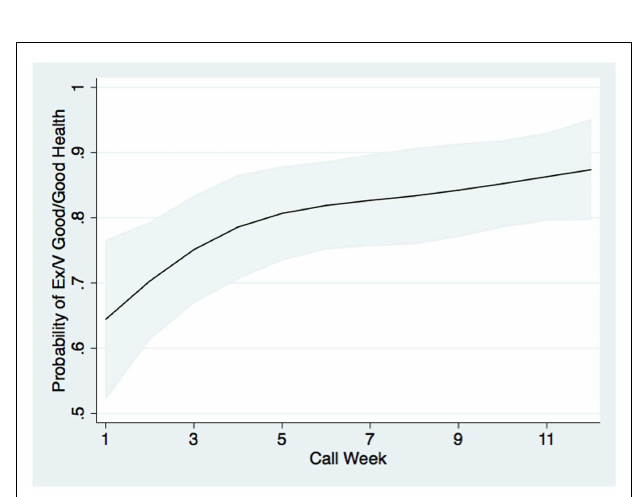
FIGURE 3 |The probability that patients completing an IVR call on a given week reported excellent, very good, or good health (versus fair or poor health) . Probabilities were estimated from a two-level multivariable logistic model using data from all IVR pilot study participants, with call weeks nested within patient, and controlling for patients’ sociodemographic, clinical, and access characteristics as shown in Table 1 . Gray bands represent 95% confidence intervals for the predicted